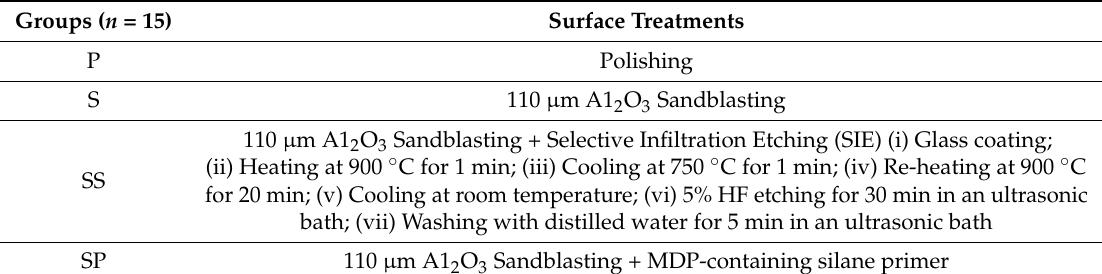
Figure 1. ( A ) Schematic illustration of mini-dumbbell specimen preparation for the tensile bond strength test (unit: mm); ( B ) Tensile bond strength testing machine and jig; ( C ) Magnified image of the specimen held by the jig (indicated by white arrow in ( B )). Table 1. Groups of 3Y-TZP (3 mol % yttria-stabilized tetragonal zirconia polycrystal) surface treatments performed in this study.